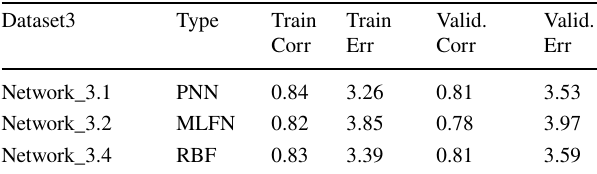
Table 9 Results of evaluation of various networks for the third set of data